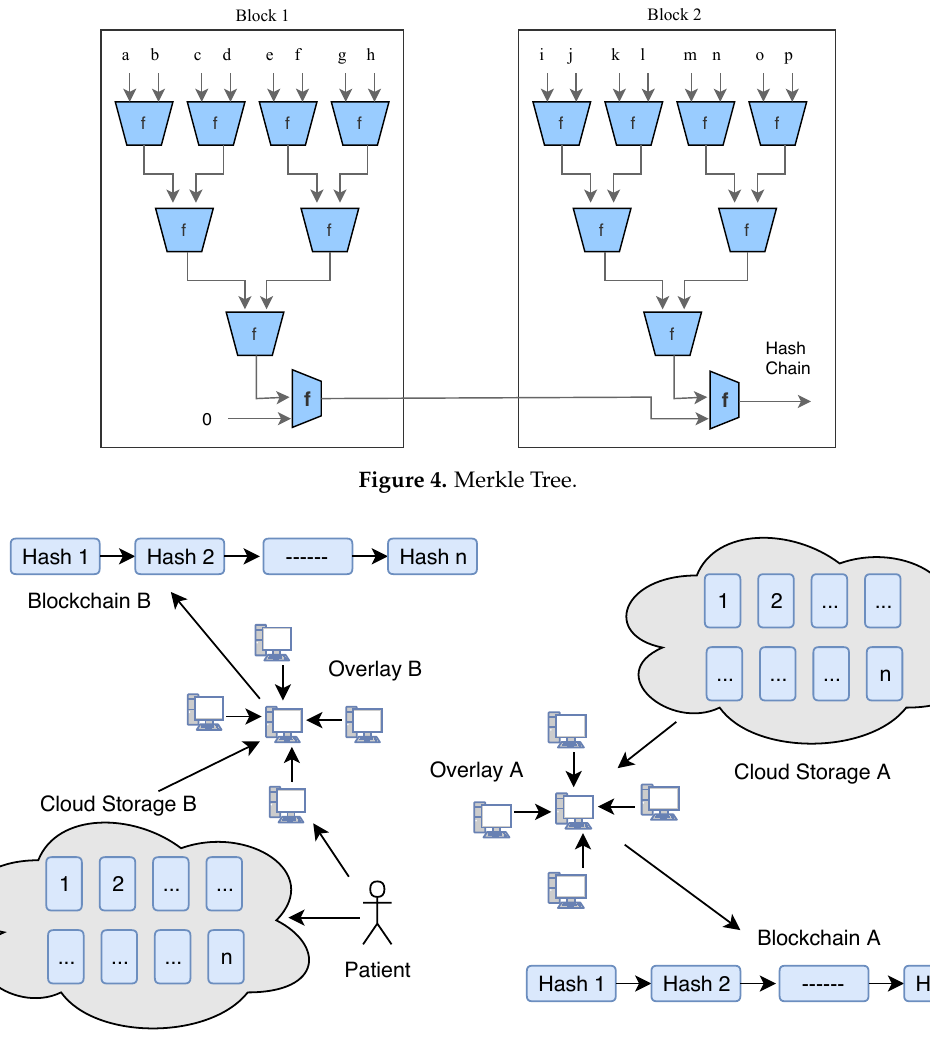
Figure 5. Overlay